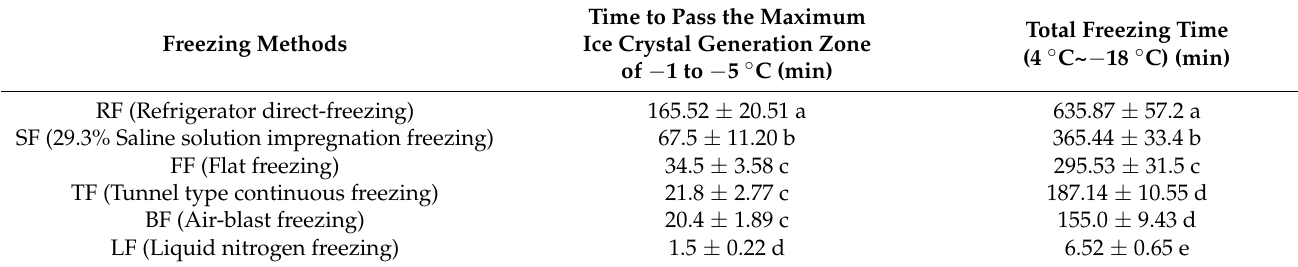
Table 1. Comparison of freezing time of cuttlefish under different freezing